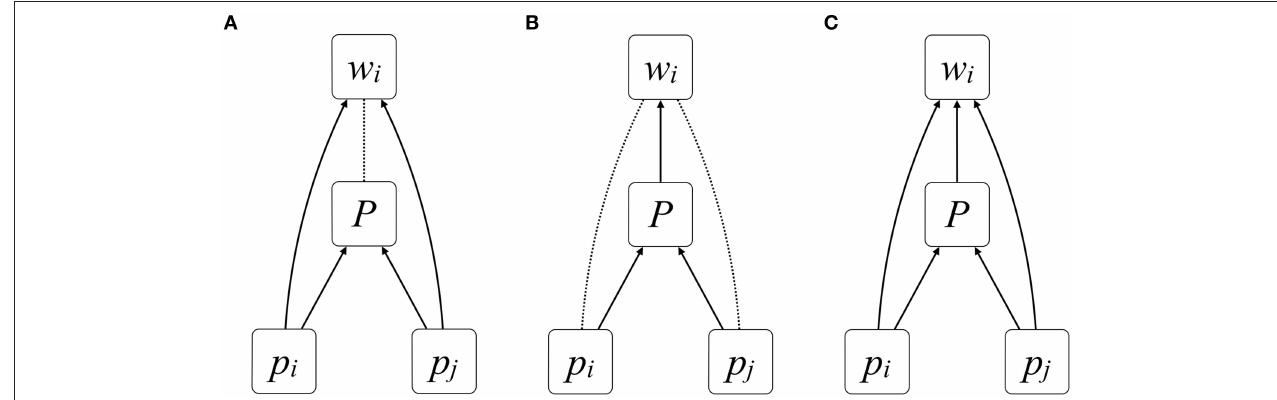
FIGURE 1 | Causation, correlation, and individual vs. group characters. Solid arrows denote direct causal effects of one variable on another, whereas dotted lines denote correlations between them. Fitness, w i , can be directly affected by (A) individual traits p i and p j alone, (B) the group trait P alone, or (C) both individual and group traits p i , p j , and P . The group trait P is functionally relevant in (B,C) because it has a direct causal effect on fitness and, therefore, selection; it is not relevant in (A) because it exerts no influence on